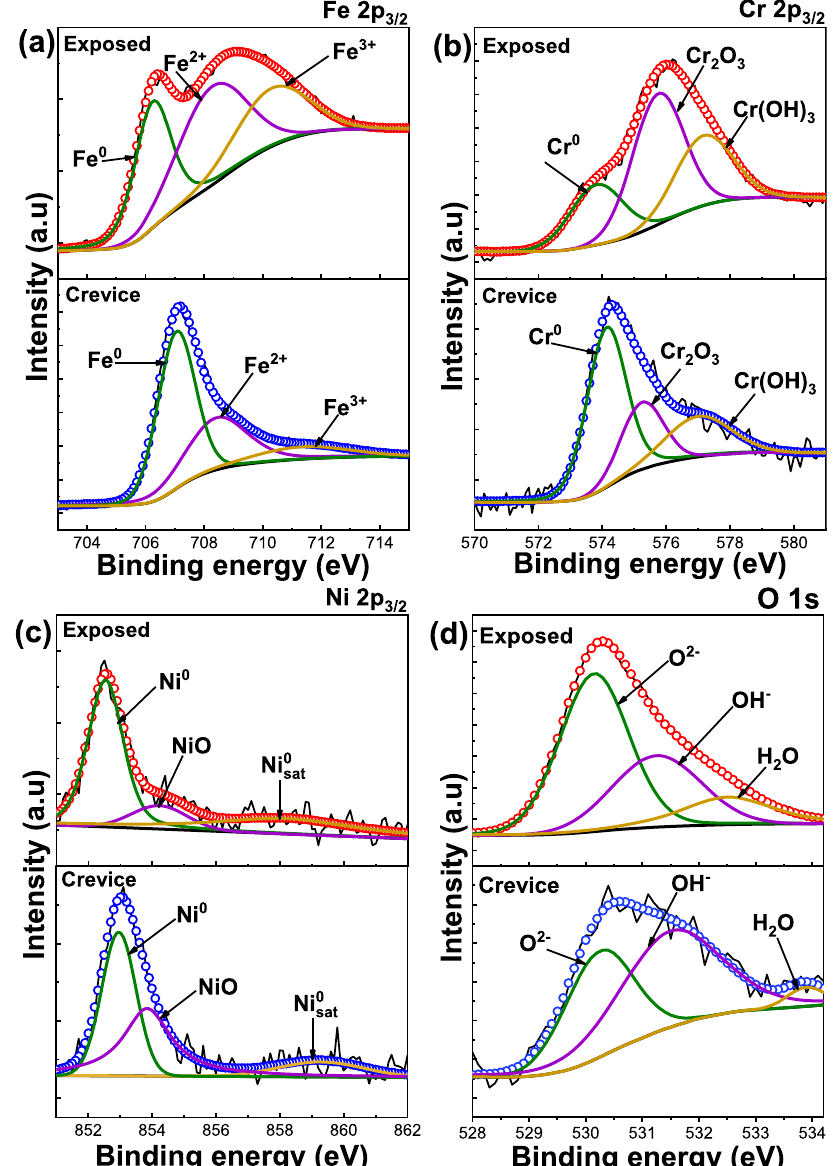
Fig. 4 Detailed XPS spectra for the oxide fi lm formed on the surfaces of the exposed and crevice samples, respectively after immersion in the test media for 30 days. a Fe 2p 3/2 , b Cr 2p 3/2 , c Ni 2p 3/2 , and d O